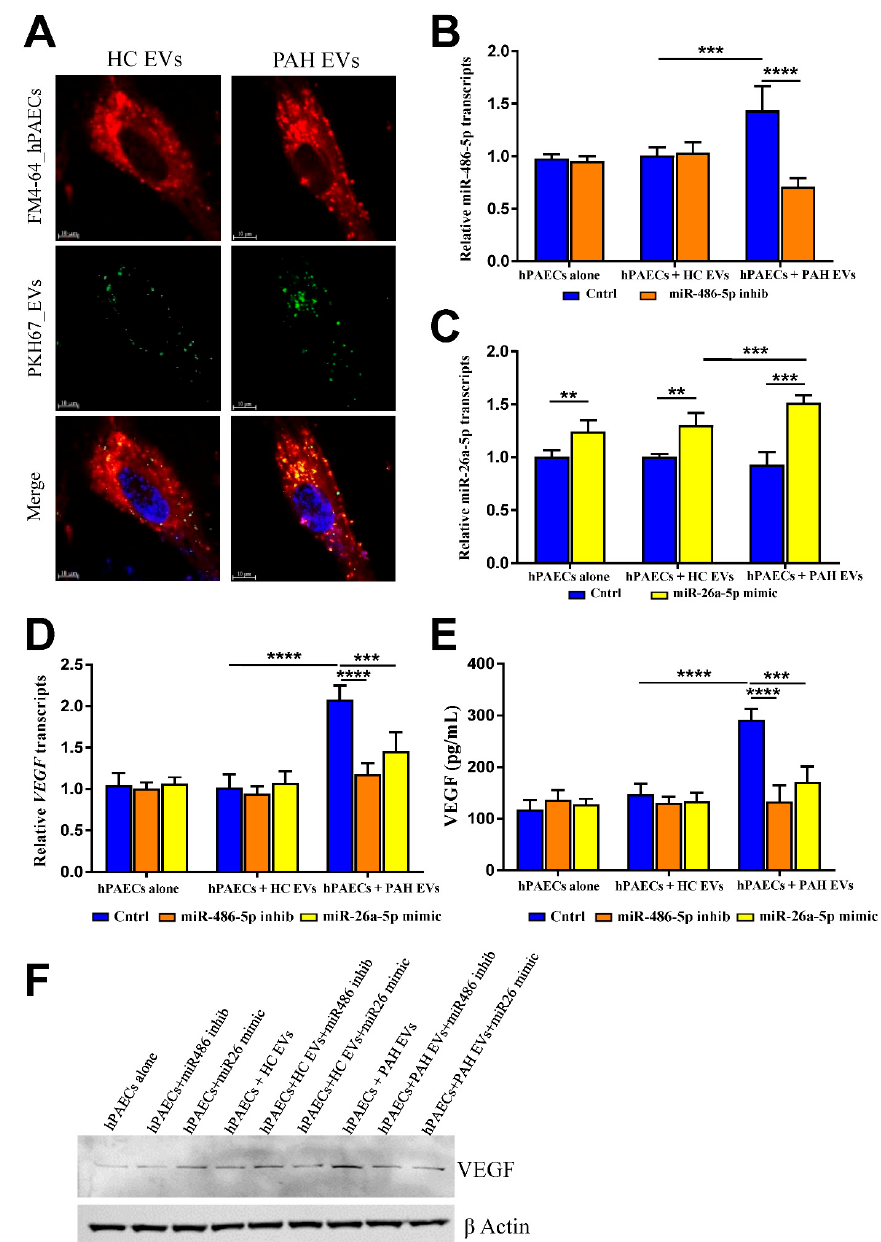
Figure 3. ( A ) HPAECs were exposed to PKH67-labeled EVs for 1 h at 37 ◦ C to facilitate their internalization. After 45 min of incubation cells were labeled with FM4-64FX dye for an additional 15 min followed by fixation, mounting, and confocal analysis. The experiment was performed 3 times, and representative images from at least 15 images per sample are shown. Expression levels of miR-486- 5p ( B ) and miR26a-5p ( C ) were quantified using qRT-PCR relative to GAPDH mRNA within hPAECs following miR inhibitor or mimic transfection post EVs incubation. ( n = 5 per group). ( D ) VEGF mRNA transcripts were quantified using qRT-PCR in hPAECs related to its GAPDH housekeeping gene ( n = 5 per group). ( E ) ELISA analysis to detect the concentrations of proangiogenic VEGF-A in hPAEC culture supernatant pre-incubated with EVs. Results are from n = 5 biological replicates and indicated as mean value with SD. ( F ) Representative western blot of VEGF-A together with β -actin loading control on hPAEC lysate pretreated with EVs followed by transfection of miR inhibitor or miR mimic ( n = 3). Data were analyzed by two-way ANOVA. ** p < 0.01, *** p < 0.005 and **** p <